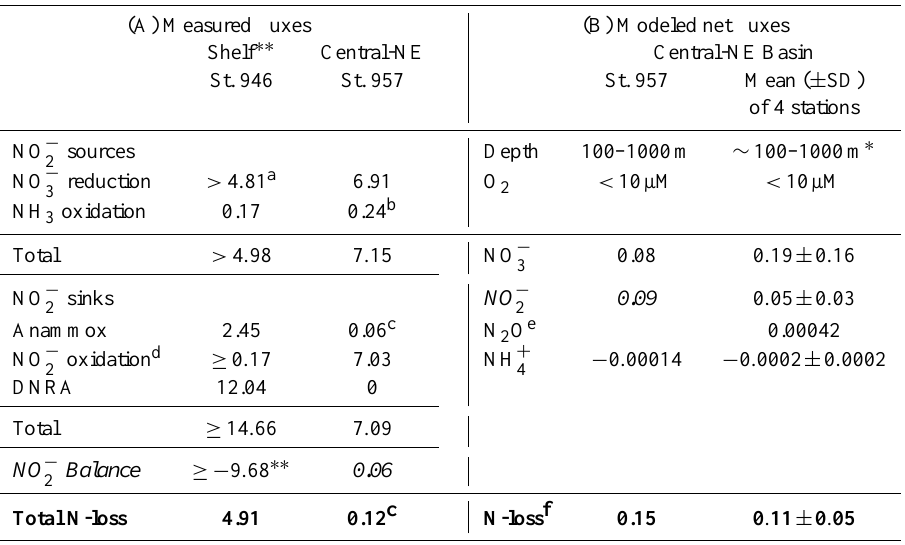
Table 1. (A) Estimated depth-integrated rates of NO − the central-northeastern basin, based on rates measured via 15 N-incubation experiments. (B) Modeled fluxes of NH + net N-loss in the central-northeastern Arabian Sea OMZ. All rates are expressed in units of mmolNm − 2 d − 1 . The net NO − central-NE OMZ estimated from the measured and modeled fluxes are highlighted in italic for comparison. The respective integrated N-loss estimates are indicated in